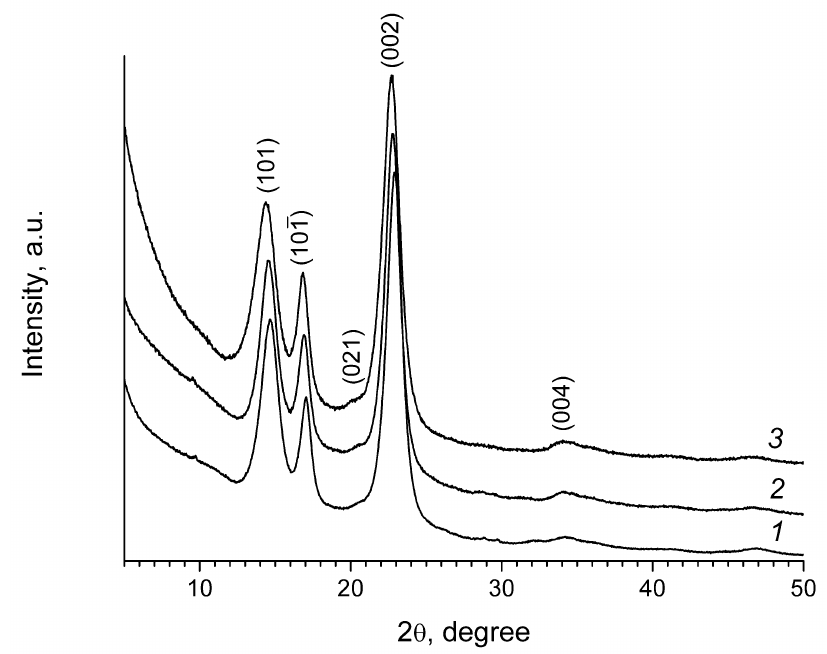
Figure 2. X-ray diffraction patterns of untreated bacterial cellulose (1) and samples treated with CBHSc for 240 min (2) and 24 h (3).